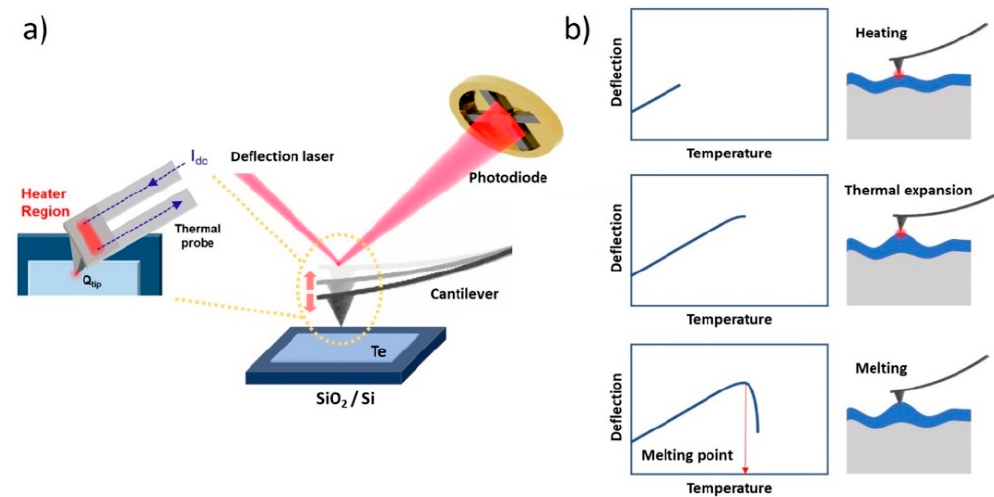
Figure 2. ( a ) Schematic and ( b ) principles of Nano TA.